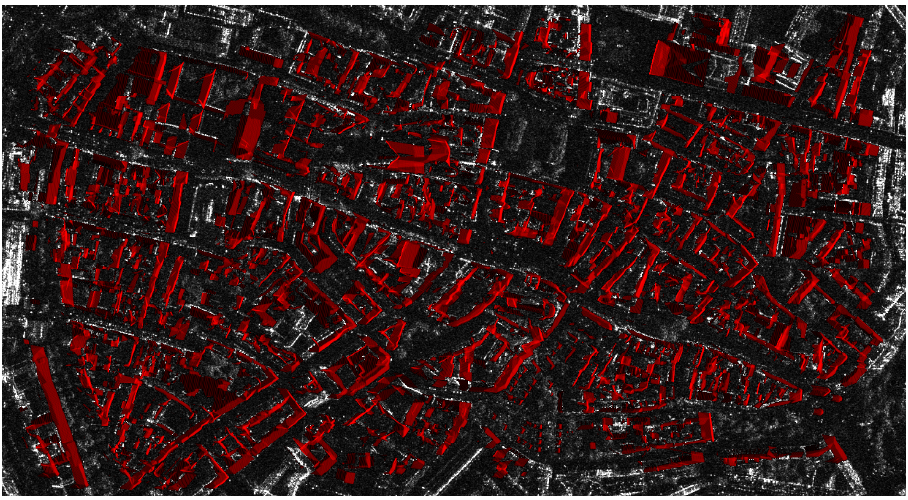
Figure 8. Simulation result based on CityGML